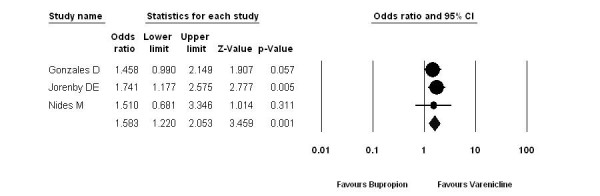
Random Effects Meta-Analysis. Varenicline vs. Bupropion at 12 months. I2 = 0%.